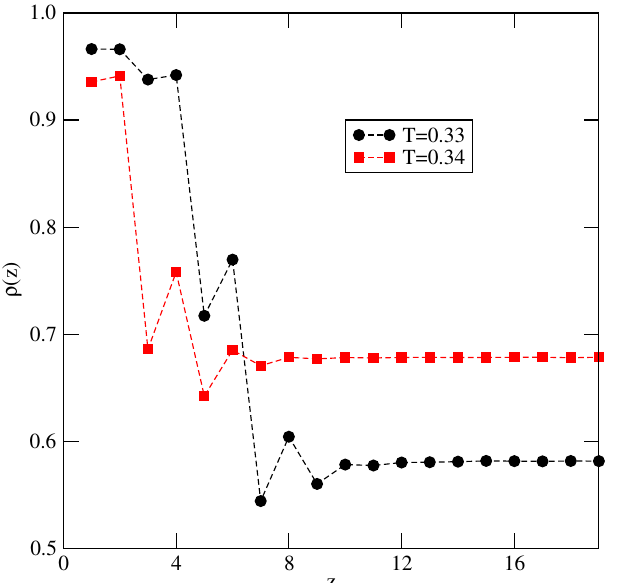
Figure 15. The local density profiles recorded at T = 0.33 and µ = − 0.88 (circles) and at T = 0.34 and µ = −